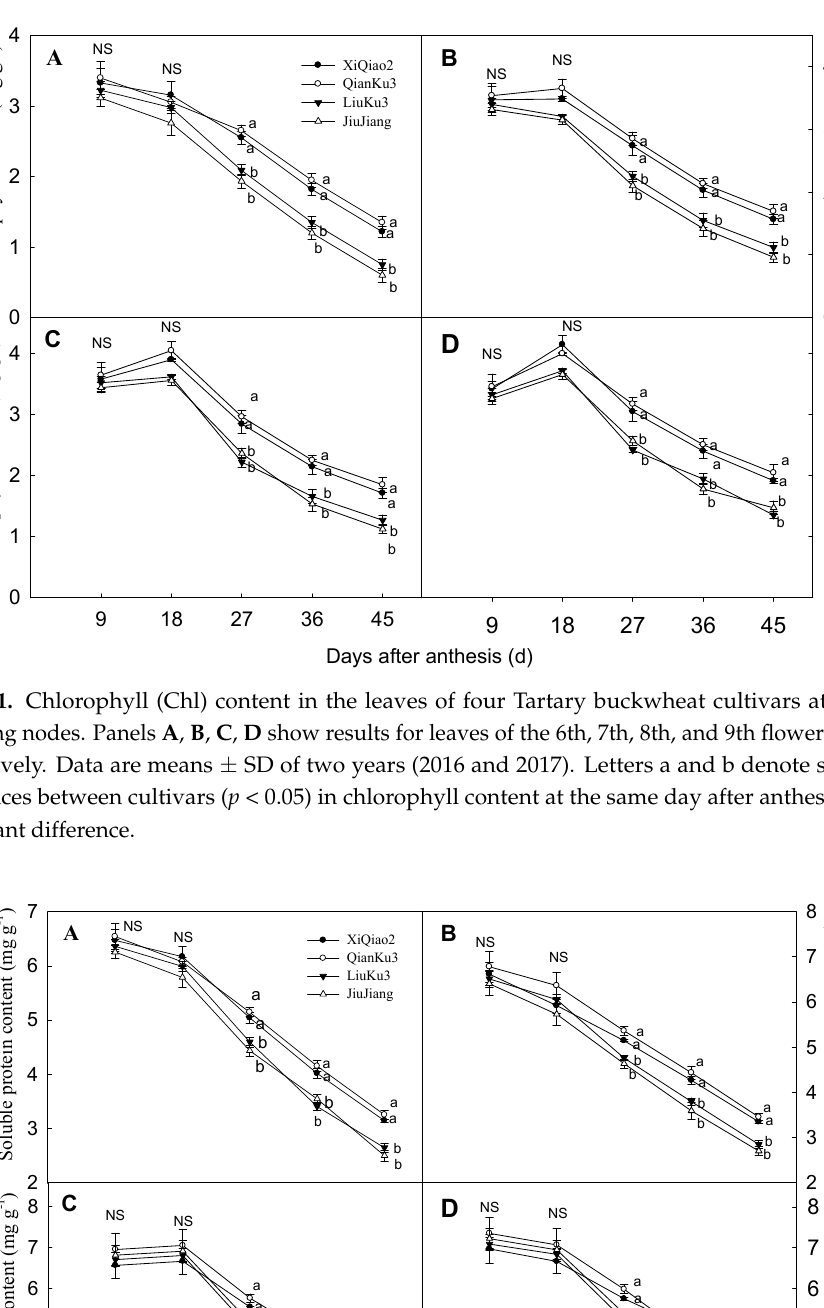
Figure 1. Chlorophyll (Chl) content in the leaves of four Tartary buckwheat cultivars at different flowering nodes. Panels A , B , C , D show results for leaves of the 6th, 7th, 8th, and 9th flowering nodes, respectively. Data are means ± SD of two years (2016 and 2017). Letters a and b denote significant differences between cultivars ( p < 0.05) in chlorophyll content at the same day after anthesis. NS: no significant difference.